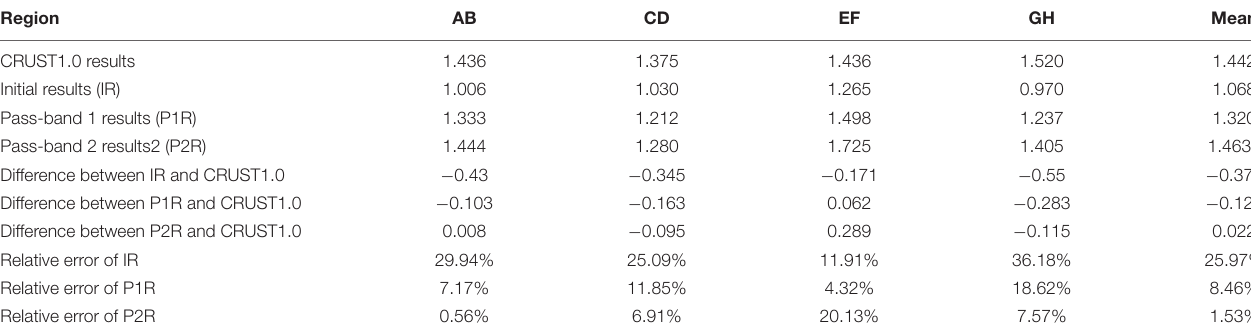
TABLE 6 | Comparisons with derived results and CRUST1.0 (unit: g/cm 3 ). Region